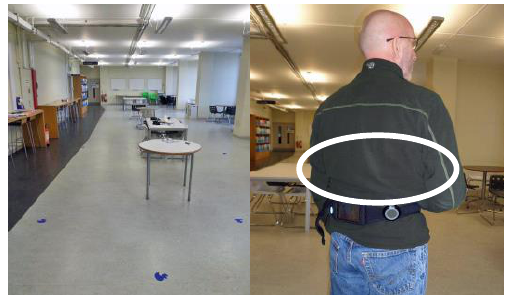
Figure 1: Study space and user with